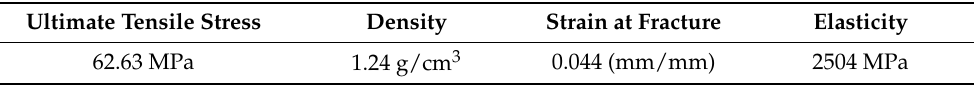
Table 1. Polylactic acid (PLA) material characteristics by the manufacturer [33].